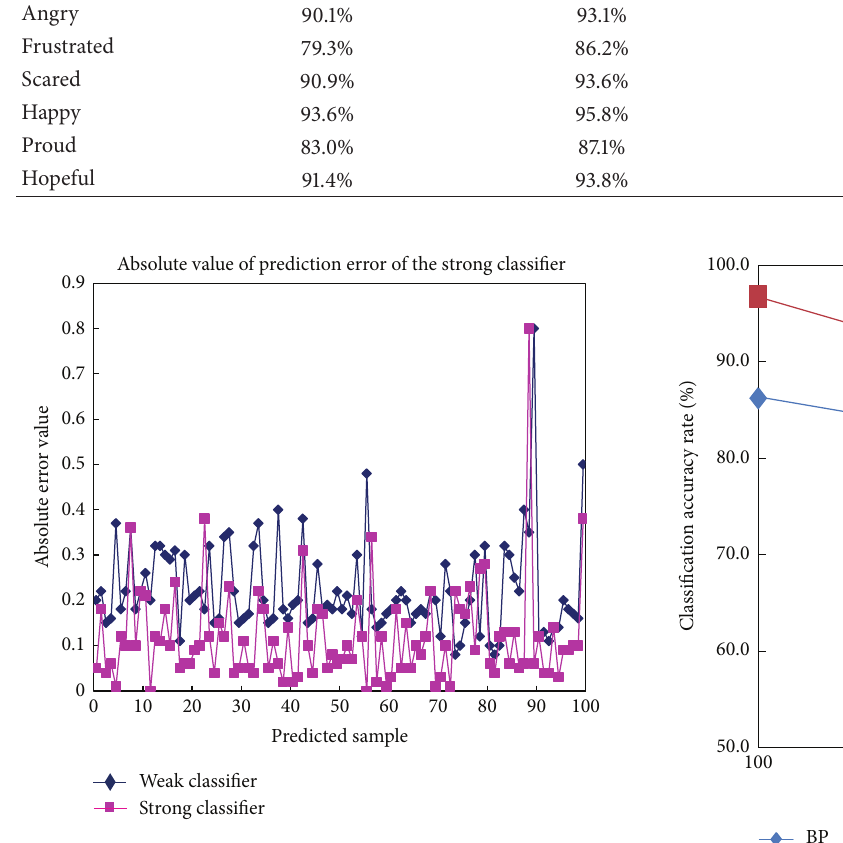
Figure 6: Absolute values of the predicted classification errorsof the Adaboost-BP neural network model.